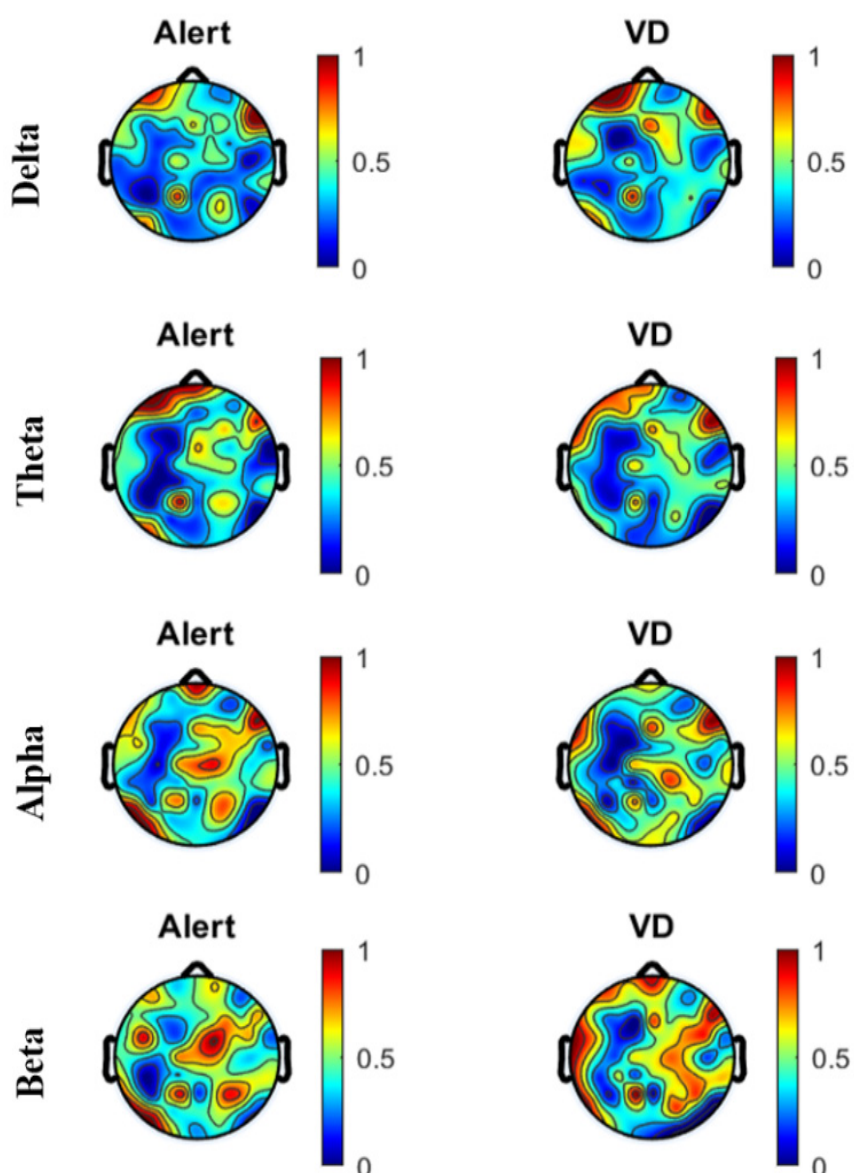
Figure 6. Comparison of PSD for all subjects under the two mental states, alert and vigilance decrement, in the four frequency bands using wICA-cleaned EEG.